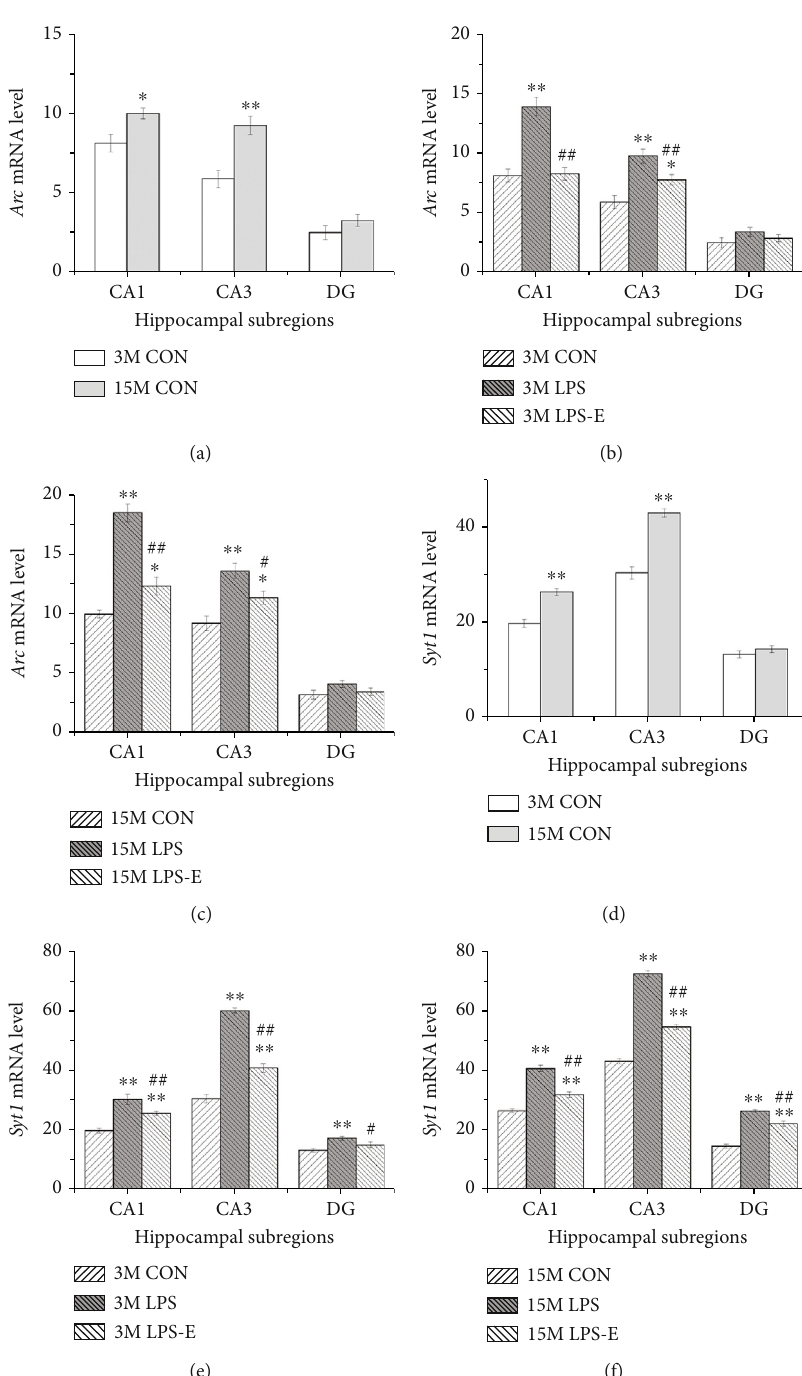
Figure 6: The expression levels of Arc and Syt1 mRNA in di ff erent hippocampal subregions in CD-1 mice. (a) Arc mRNA and (d) Syt1 mRNA levels in di ff erent hippocampal subregions (CA1, CA3, and DG) at di ff erent ages in the control groups. (b, c) Arc mRNA and (e, f) Syt1 mRNA levels in di ff erent hippocampal subregions (CA1, CA3, and DG) in the di ff erent treatment groups ( n = 6 per group) at 3 months of age (b, e) and 15 months of age (c, f). The relative mRNA level was calculated as the number of positive cells